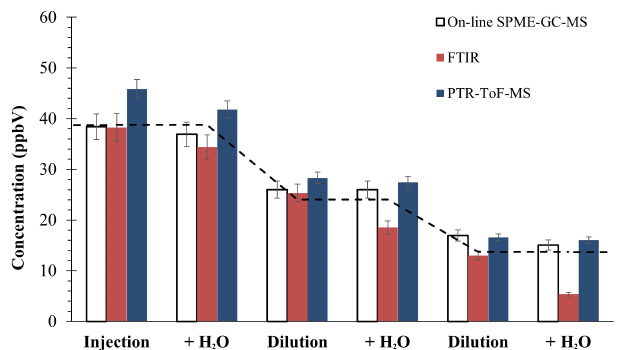
Figure 2. Average concentration of methylglyoxal provided by on-line SPME–GC–MS, FTIR, and Ionicon PTR-ToF-MS (from Jülich). The dashed line indicates the theoretical value, according to the quantity injected into the chamber, and the steps show this adjusted value with the dilution of the chamber (according to SF 6 values). Errors from SPME and FTIR include precision and accu- racy; PTR-ToF-MS error shows 3 σ of precision (did not include